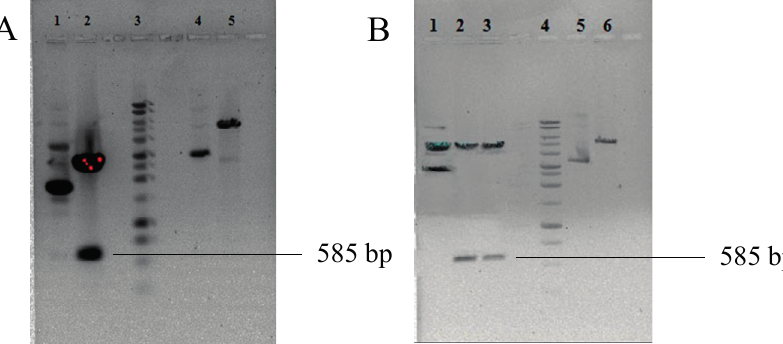
Figure 1. Construction of hybrid HBcAg VLP. B (green color) represents the linear and conserved protective B-cell epitope SHLQLIYNL. T1 represents the conserved protective T-cell epitope KGRLYRWRSPVIIEK. T2 represents the conserved protective T-cell epitope LAALICFVIRLAKNC. There is a His 6 -tag at the N -terminal of the protein.